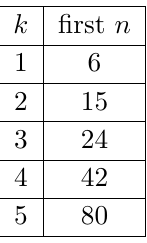
2 ; (cid:1) (cid:1) (cid:1) ; T k fail to generate the centre